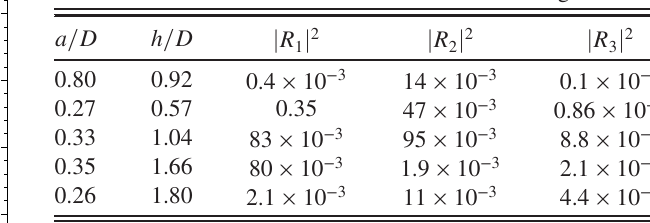
TABLE II. Reflection coefficients for η ¼ ζ ¼ 0 ° and β ¼ 0 . 548 in the first three radiation orders n and different geometries.